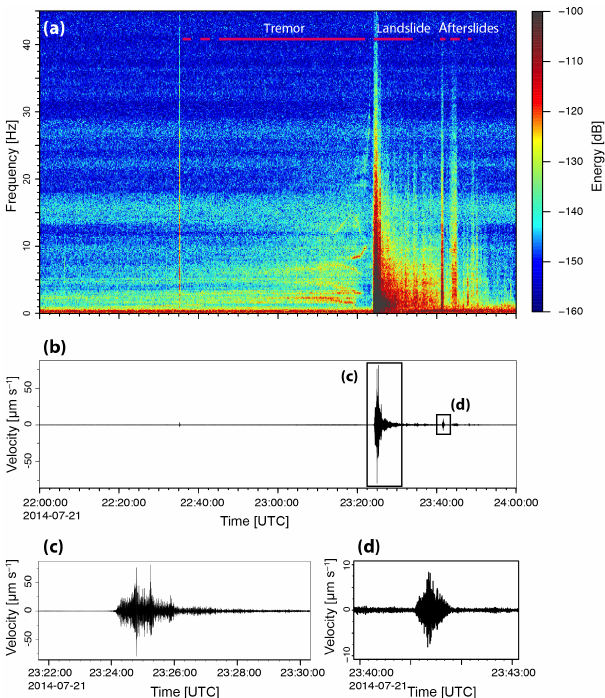
Figure 4. (a) Spectrogram (unfiltered) and (b) waveform (filtered between 1 and 45Hz) of the landslide, its precursory tremor and the afterslides at the Askja caldera, 21 July 2014. (c) Close-up of the landslide and (d) of one afterslide waveform. MOFO station, east